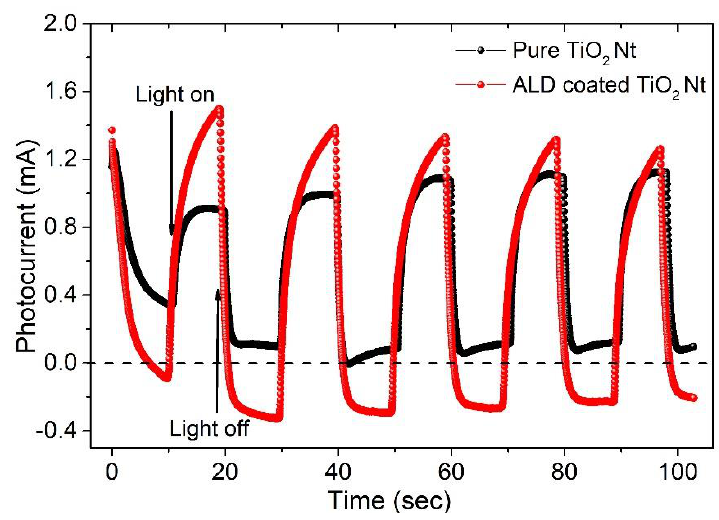
Figure 9. Transient photocurrent responses under Ultraviolet–Visible (UV-Vis) light irradiation.